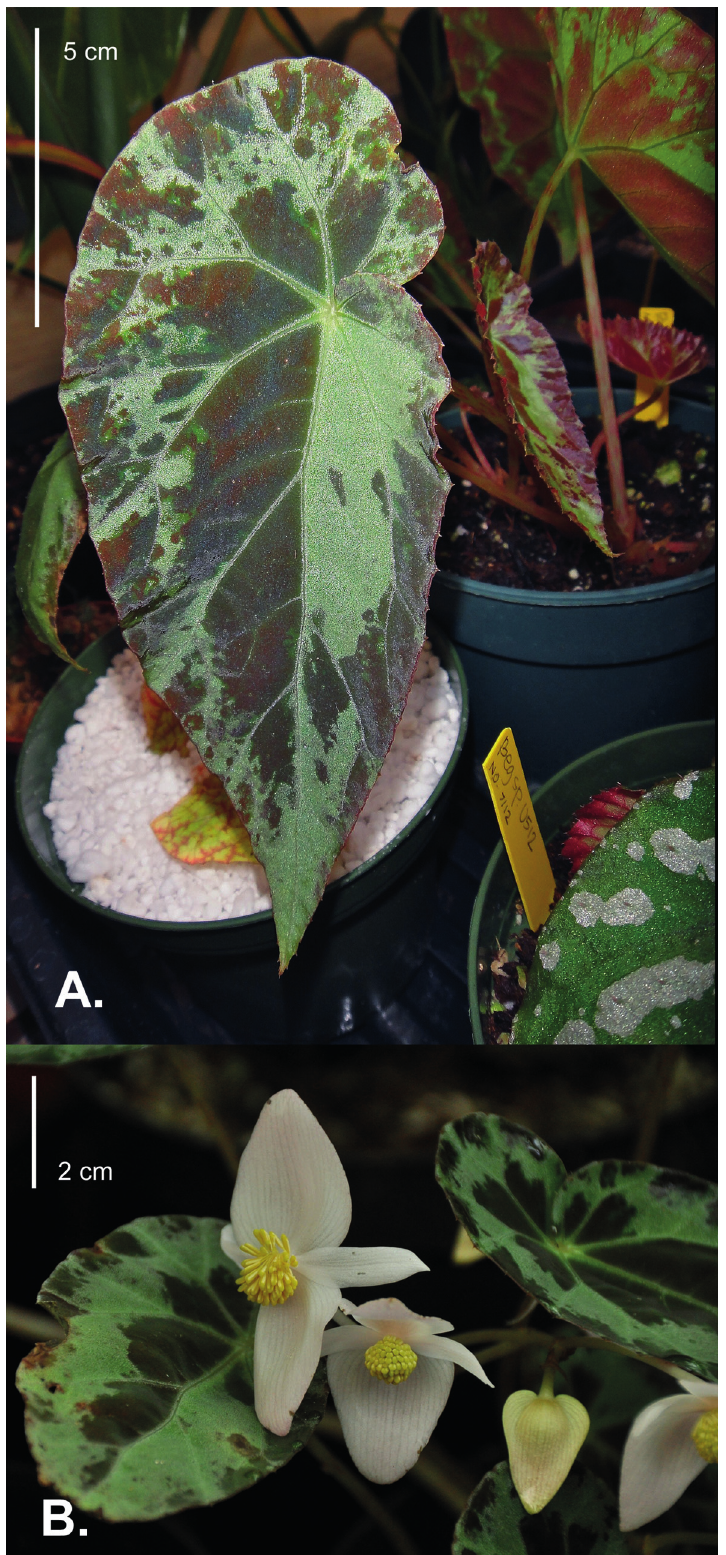
Fig. 17. Begonia burkillii Dunn. A . Leaf pattern. B . Male flowers. Photograph A courtesy of Aaron Matsumoto and photograph B courtesy of Earl I-Lan of plants in cultivation in private